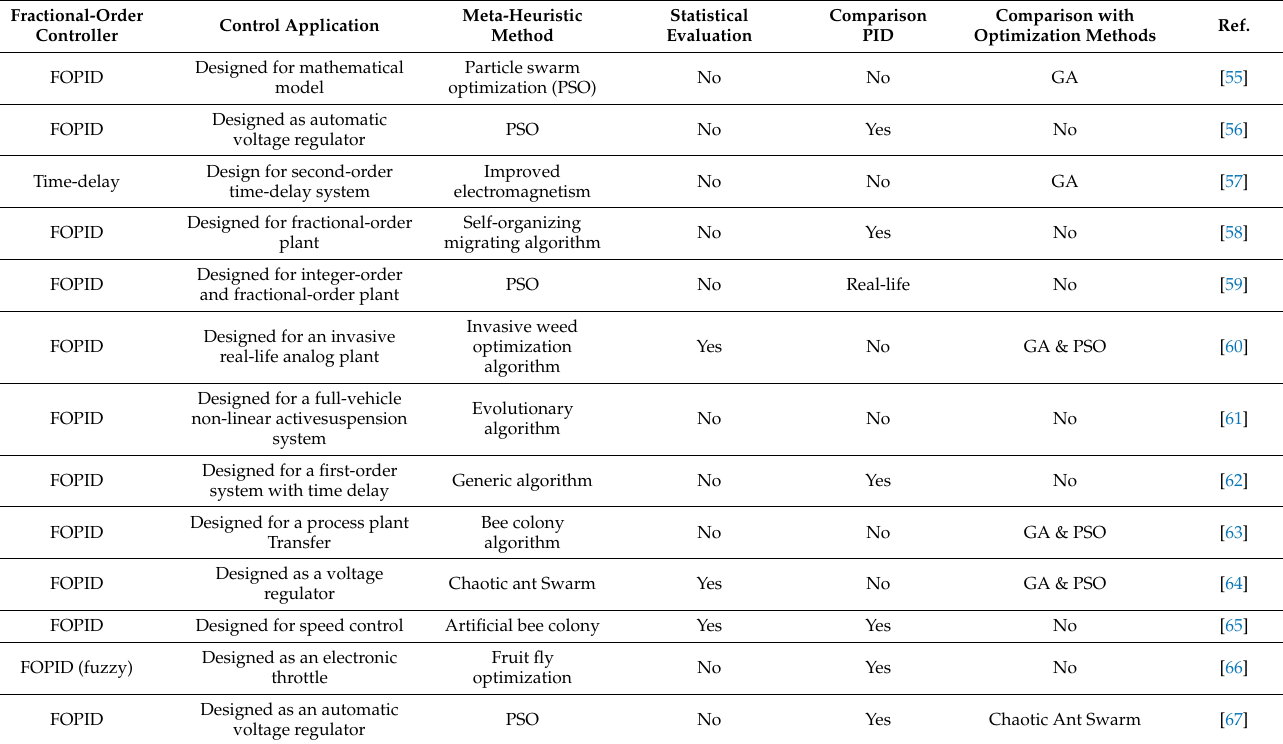
Table 1. Usage Comparison of fractional-order PID